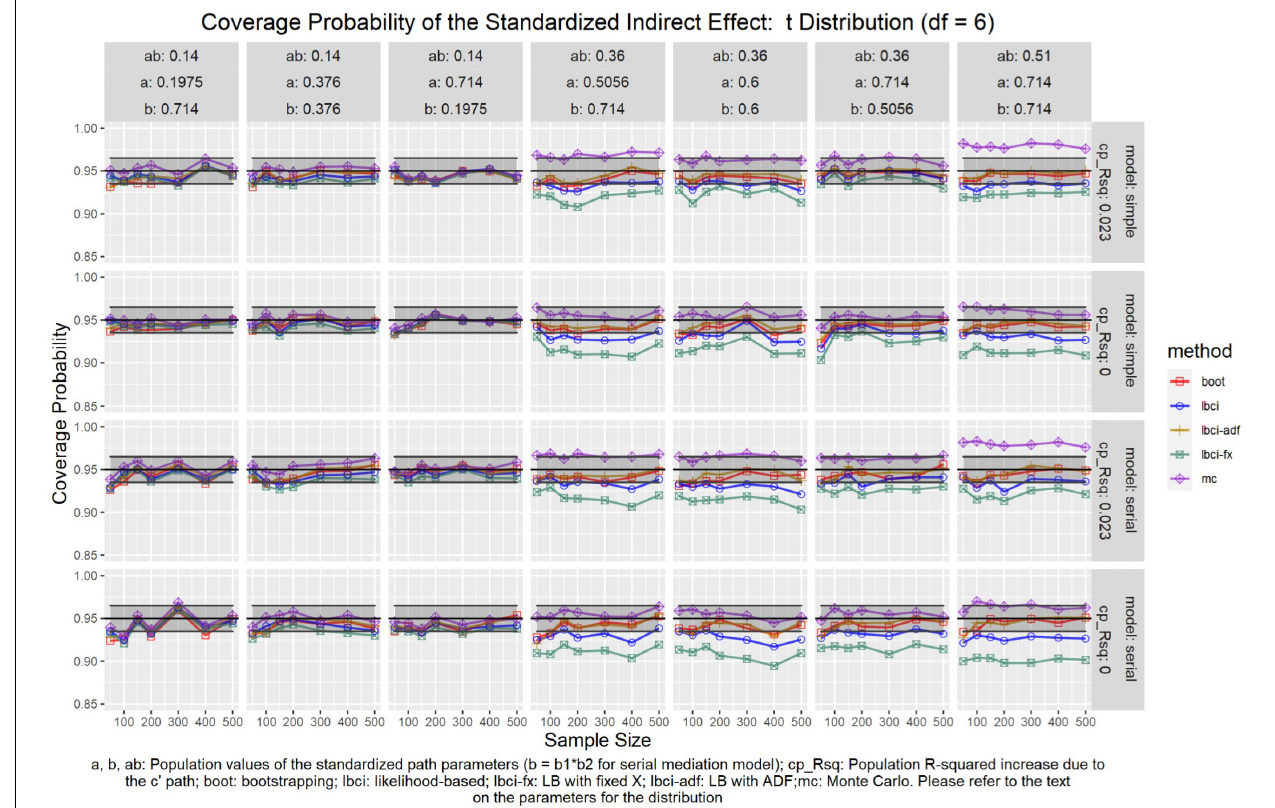
FIGURE 14 | t (6) Distribution (Standardized Indirect Effect). a, b, ab: Population values of the standardized path parameters (b = b1 × b2 for serial mediation model); cp_Rsq: Population R-squared increase due to the c (cid:48) path; boot: bootstrapping; Ibci: likelihood-based; Ibci-fx: LB with fixed X; Ibci-adf: LB with ADF;mc: Monte Carlo. Please refer to the text on the parameters for the